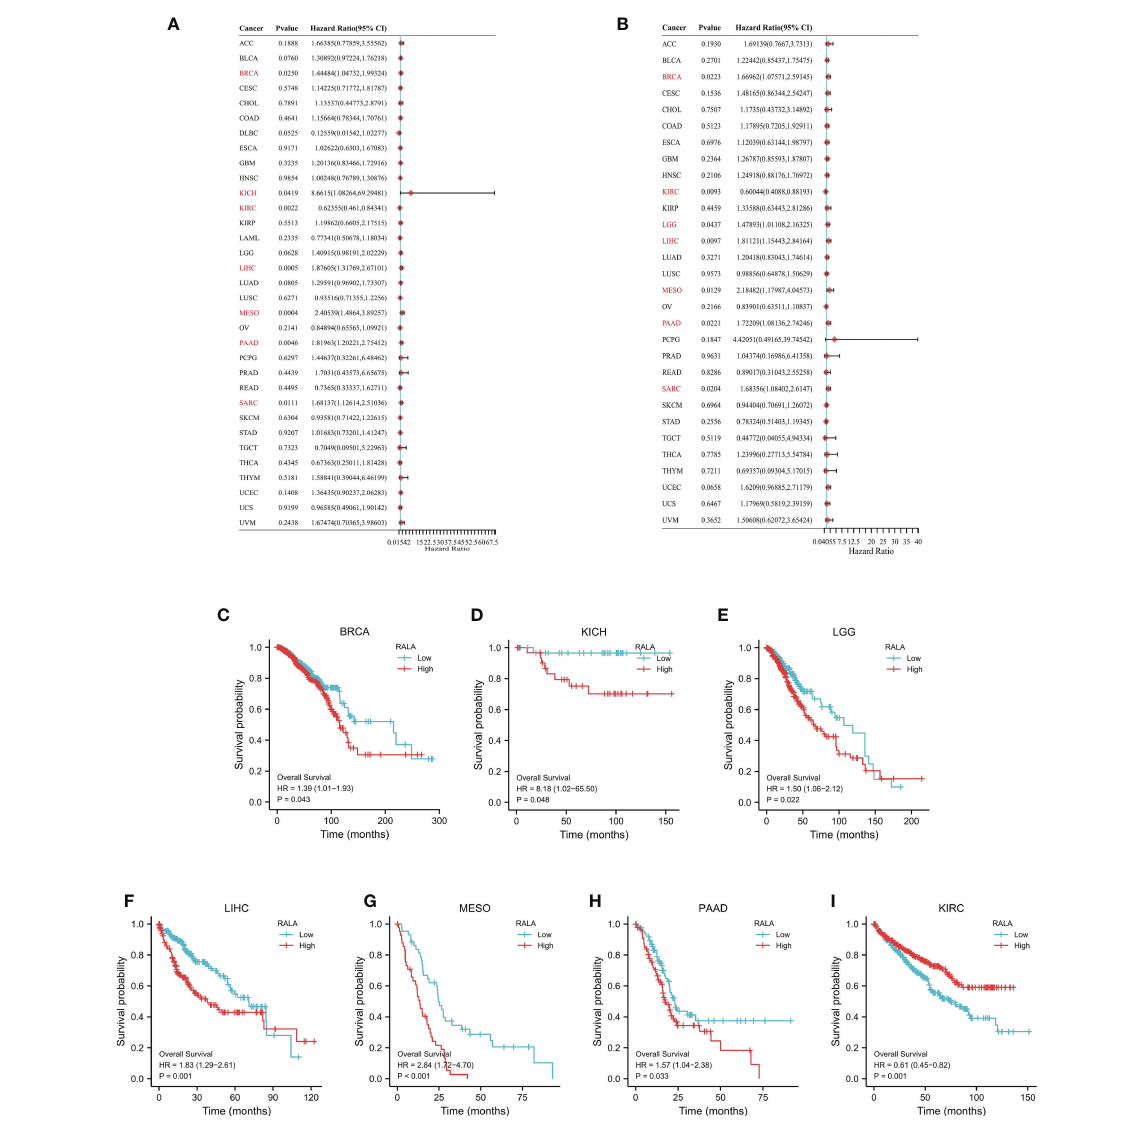
RALA gene is the deep deletion of the gene. In addition, RALA gene has almost no mutation in Follicular Thyroid Cancer, Desmoplastic/Nodular Medulloblastoma, Cervical squamous cell cancer and endocervical adenocarcinoma (CESC), LAML, Chronic Lymphocytic Leukemia/Small Lymphocytic, Essential Thrombocythemia, Follicular lymphoma, Polycythemia vera, Invasive Breast Cancer and Liposarcoma (Figure 5A). At the mRNA level, we analyzed the correlation between the mRNA obtained by RALA gene transcription in pan-cancer and the variation of tumor copy number alteration (CNA) (Figure 5B).